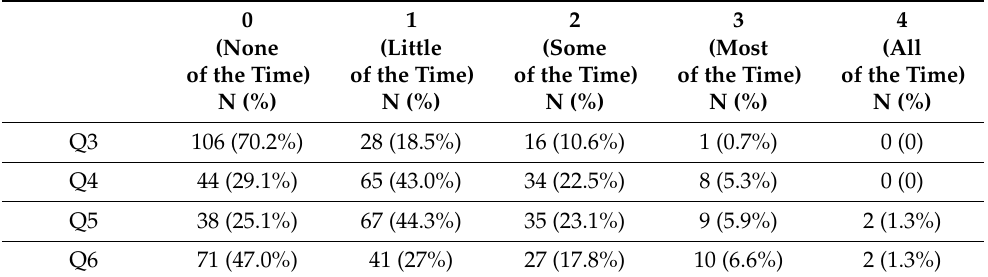
Table 1. Frequency of responses for each Oral Behaviours Checklist (OBC)